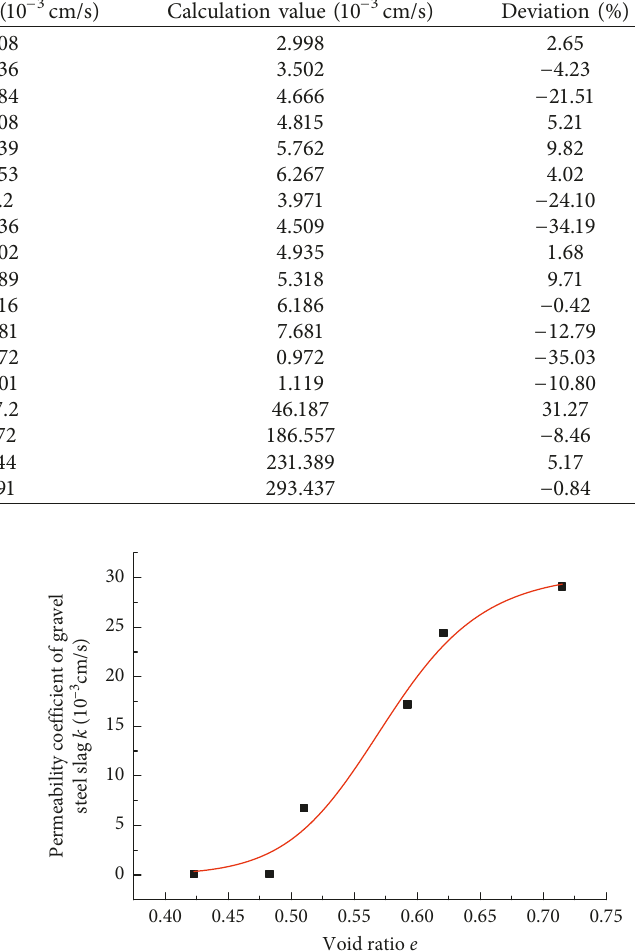
Figure 7: Fitting curve on the permeability coefficient of gravel steel